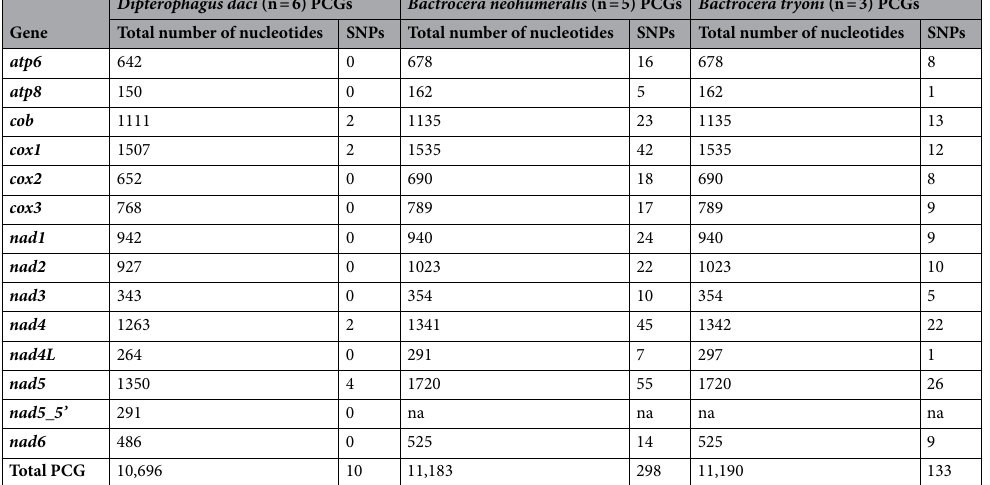
Table 3. Nucleotide diversity of the mitochondrial PCGs of Dipterophagus daci (n = 6), Bactrocera neohumeralis (n = 5) and Bactrocera tryoni (n = 3), showing the number of single nucleotide polymorphisms (SNPs). The 5’ part of the D. daci nad5 gene with the stop codon is listed separately as nad5_5’ .